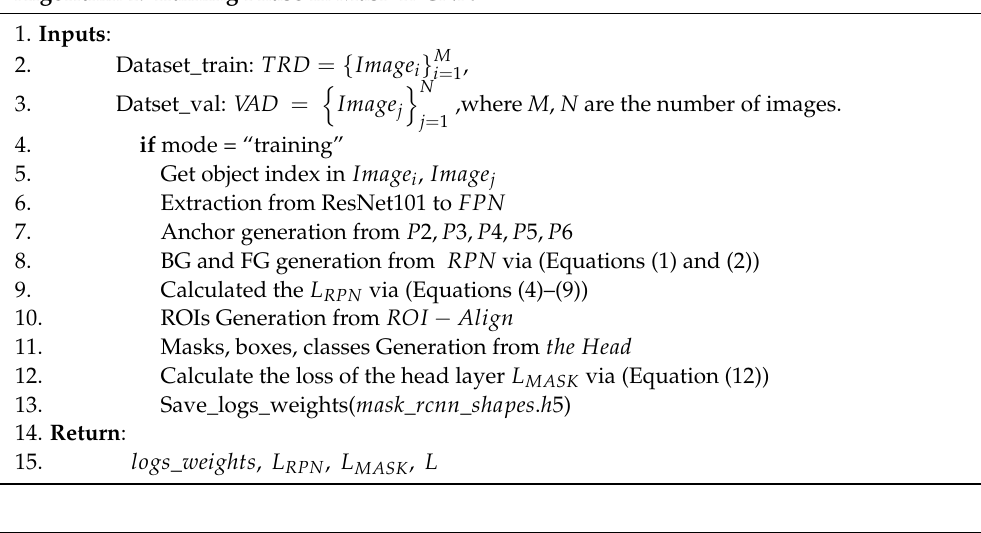
Algorithm 1. Training Phase in Mask R-CNN